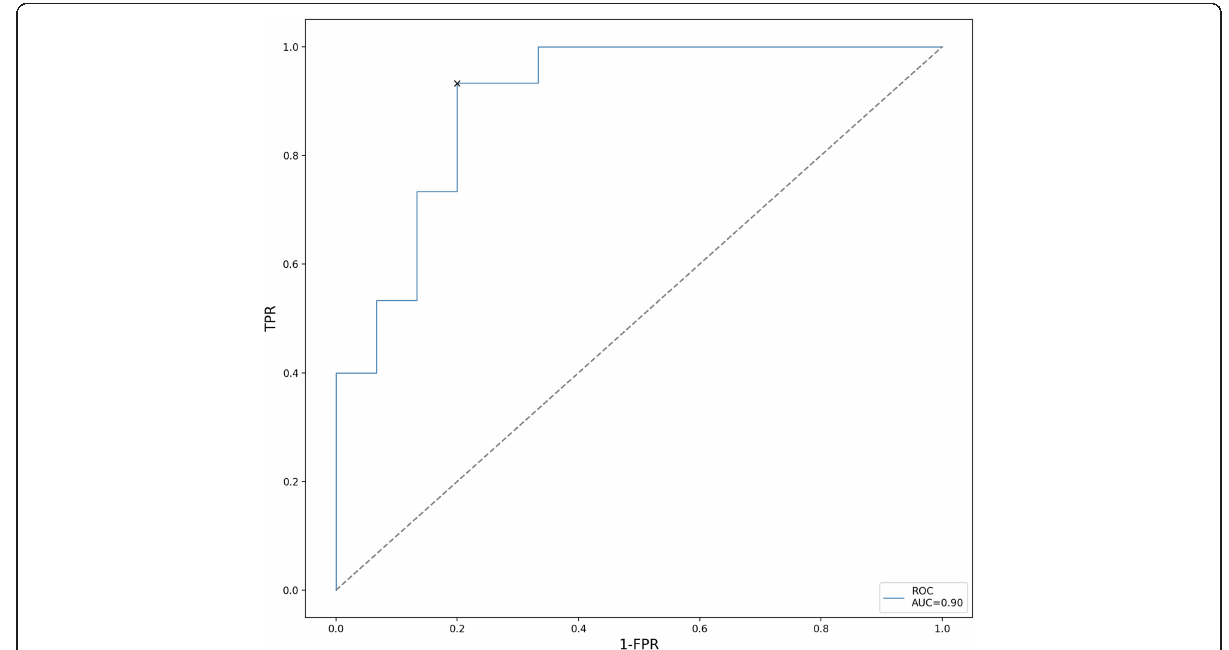
Fig. 2 Receiver operator characteristic curve of model performance of the ML algorithm for the independent validation cohort. The classification threshold was 0.5, resulting in an area under the curve of 0.9 (cross) ( n = 30